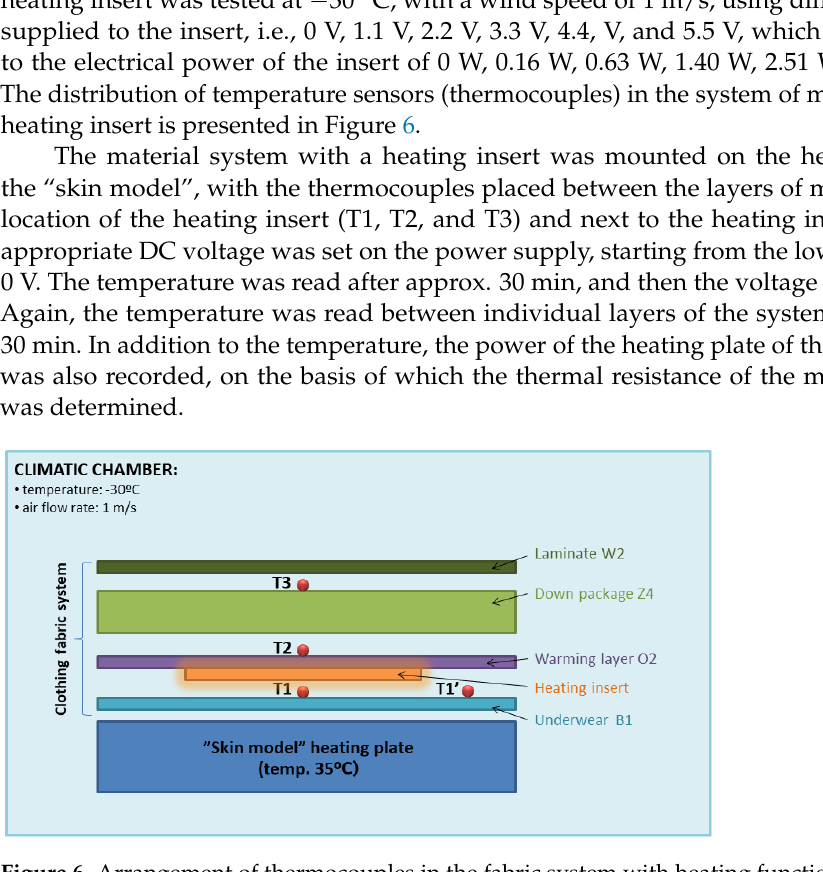
Figure 6. Arrangement of thermocouples in the fabric system with heating function for protective clothing for mountain